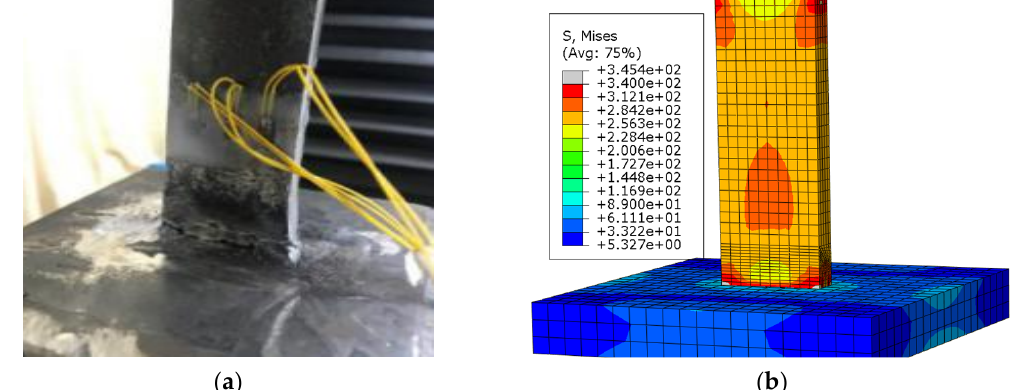
Figure 16. Results of finite element analysis and experimental testing: ( a ) experimental results; ( b ) finite element analysis.